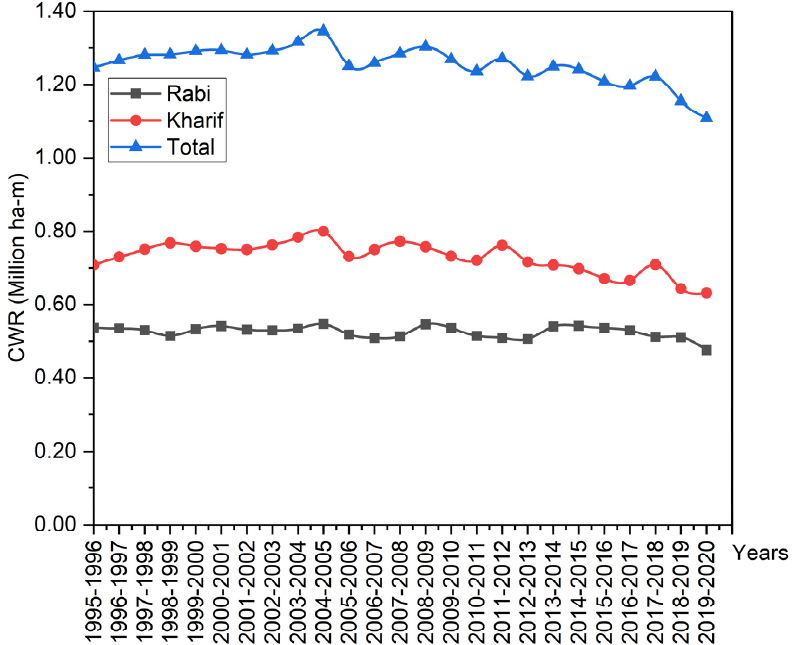
Figure 7. Temporal variation in crop water requirement during Rabi and Kharif season in LCC area.